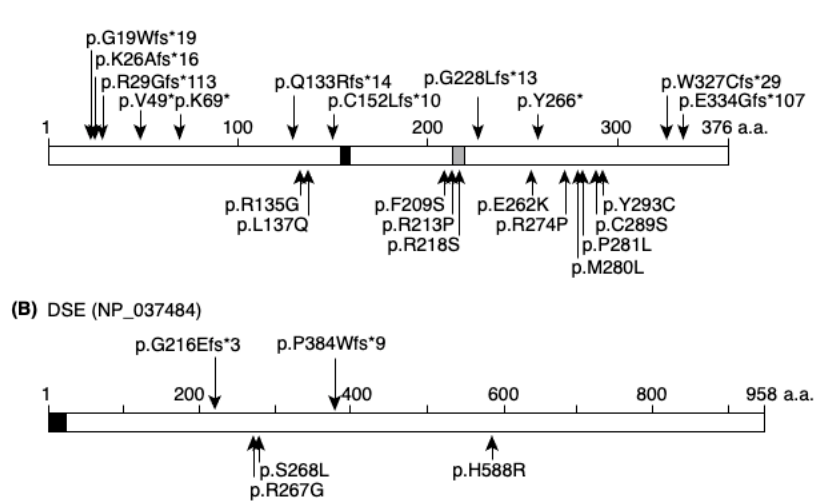
Figure 2. Published pathogenic protein changes of D4ST1 and DSE in mcEDS. ( A ) Previously published truncating and non-truncating protein alterations in D4ST1 are shown in upper and lower panels, respectively. Black box indicates 5’-phosphosulfate binding site and gray box indicates 3’-phosphate binding site. ( B ) Previously published truncating and non-truncating protein alterations in DSE are shown in upper and lower panels, respectively. Black box indicates the signal peptide.